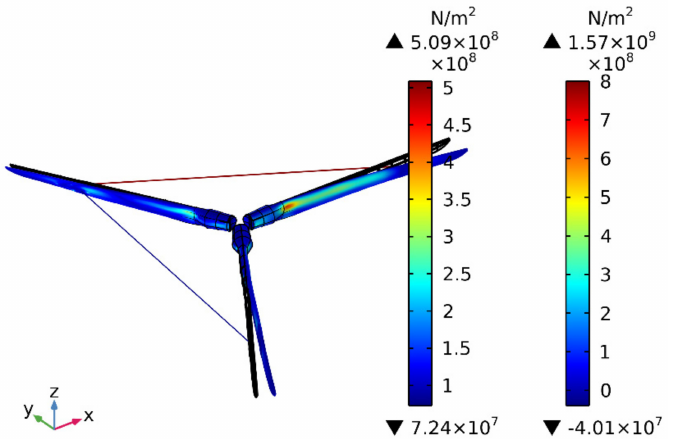
Figure 12. Stress value of RCC connected at 2 L /3.